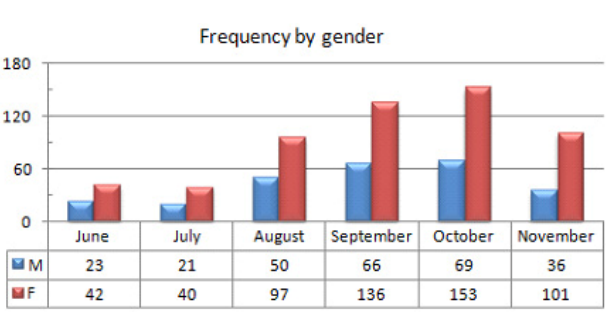
Figure 3. Guest arrivals by gender.